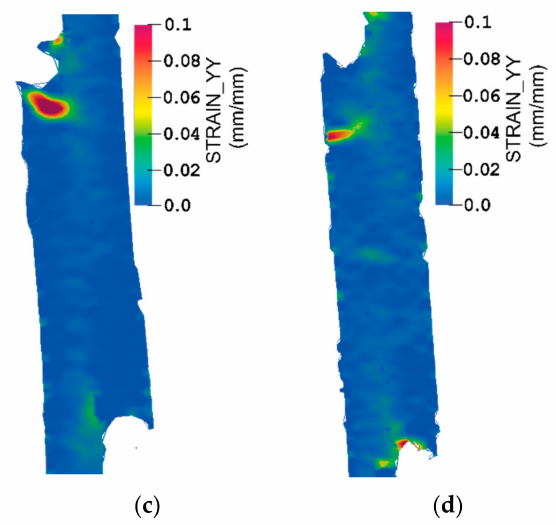
Figure 14. Pre-failure Cauchy strain_yy fields of representative ( a ) VTFA400 specimens ( b ) cured and bonded ( c ) co-cured; and ( d ) Z-pinned.